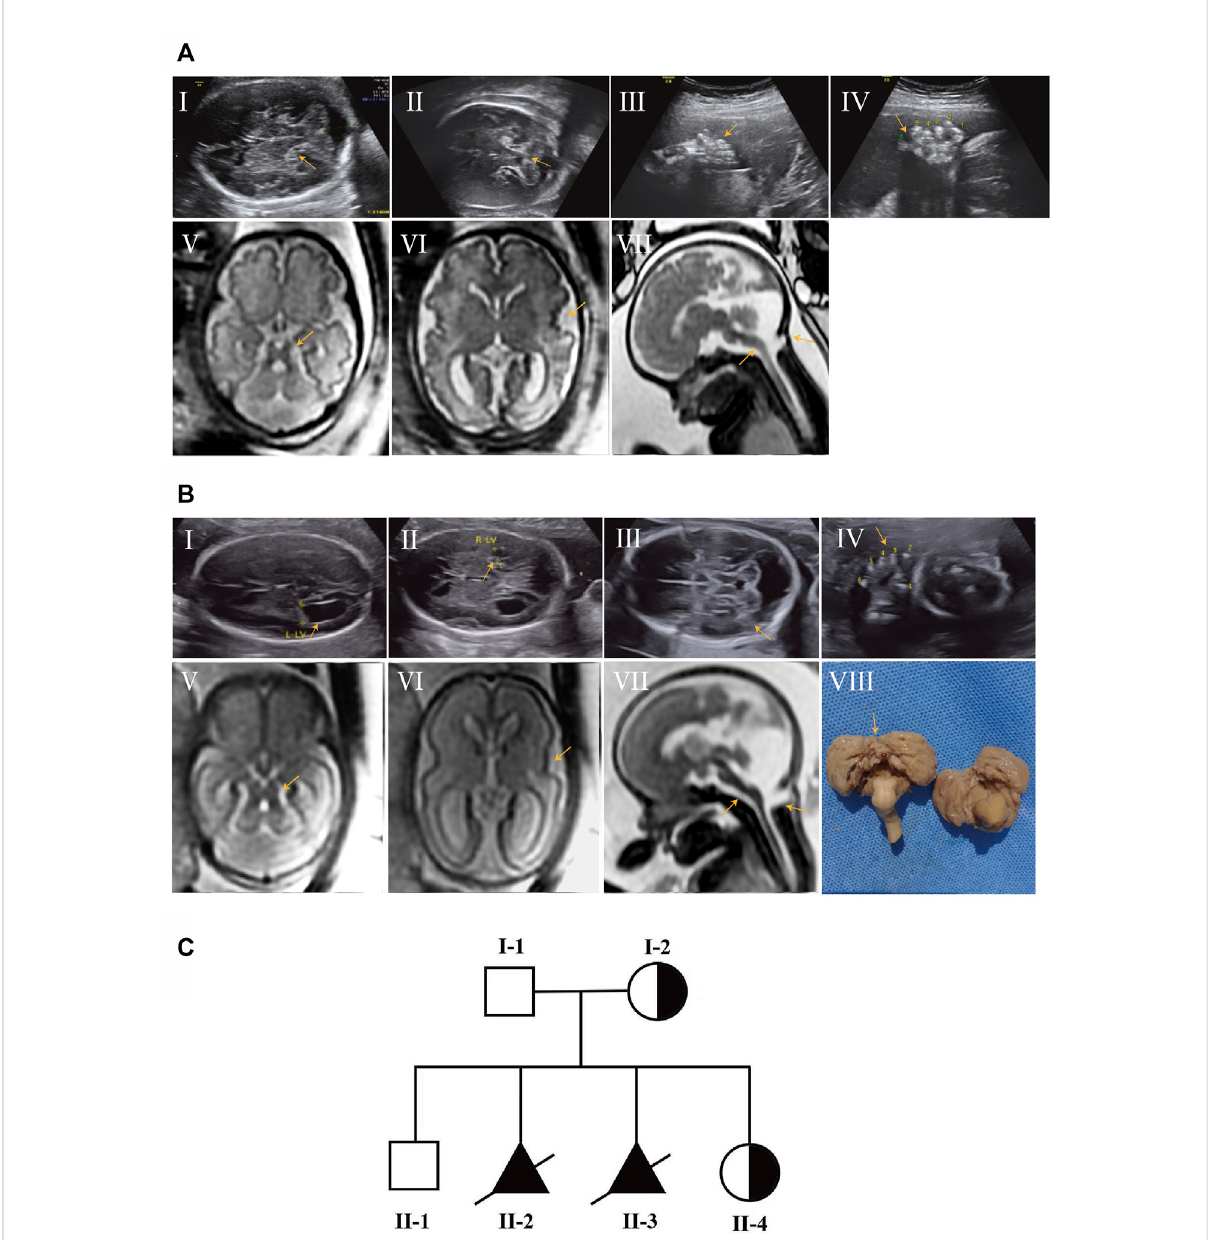
FIGURE 1 PrenatalultrasoundandfetalbrainMRI fi ndingsofaffectedsubjectsandpedigreechartofthefamilywithJBTS10. (A Ⅰ – Ⅳ ) Prenatalultrasoundof II-2 showed thickening of the superior cerebellar feet, cerebellar vermis agenesis, enlarged posterior cranial fossa (A Ⅰ , Ⅱ ) and bilateral postaxial polydactylyon thehands andrightfoot (A Ⅲ , Ⅳ ) at30 weeks ofgestation. (A Ⅴ – Ⅶ ) Brain MRI ofII-2 showed MTS (A Ⅴ ) , polymicrogyria (A Ⅵ ) ,posterior meningocele and thin brain stem (A Ⅶ ) . (B Ⅰ – Ⅳ ) Prenatal ultrasound of II-3 showed a similar anomaly to II-2 at 25 weeks of gestation. (B Ⅴ – Ⅶ ) Brain MRIof II-3; polymicrogyria wasnot obviouscompared with II-2. (B Ⅷ ) Autopsy result ofII-3 showed absent cerebellar vermis. (C) Pedigrees of the family with JBS10 pro fi led in this